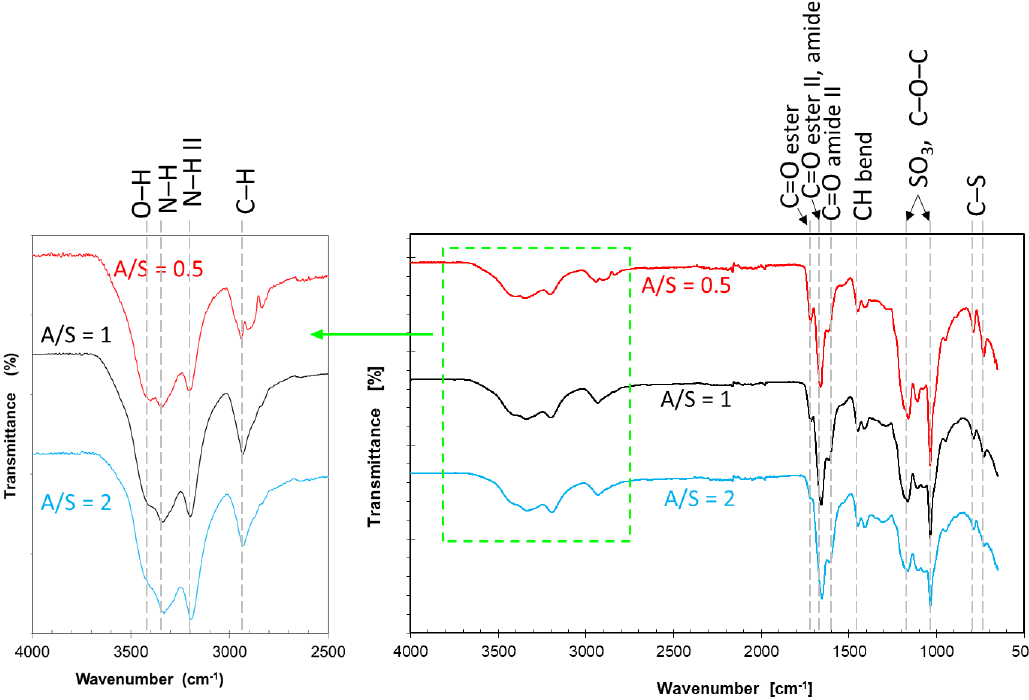
Figure 2. FTIR spectra of HPMC-g-poly(AM-co-SPA) hydrogels. The spectra were overlaid after being calibrated to possess the same intensity of the carbonyl peak at 1660 cm − 1 . Changes in hydrogen bonding would lead to changes in